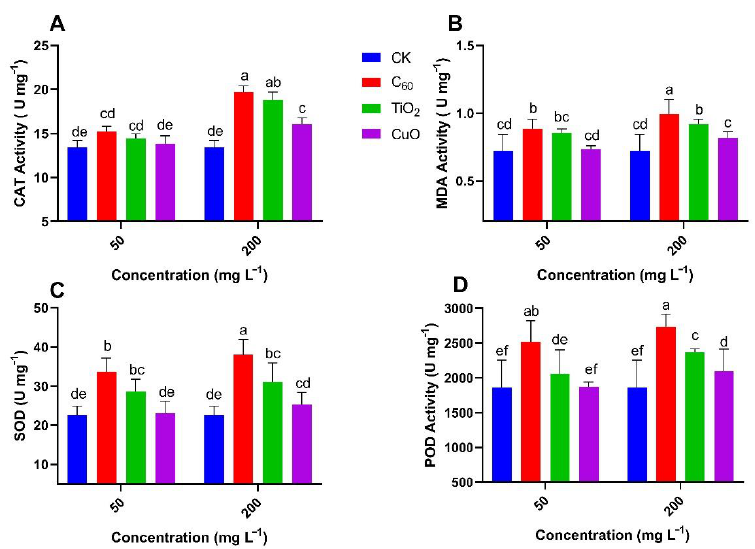
Figure 7. Effect of NMs treatment on the mean content (n = 3) of ( A ) catalase, ( B ) malondialdehyde, ( C ) superoxide dismutase, and ( D ) peroxidase enzymes in sweet potato (Y25) exposed to soft rot disease. Different small letters represent significant difference according to Duncan’s multiple range test ( p < 0.05. n = 3).